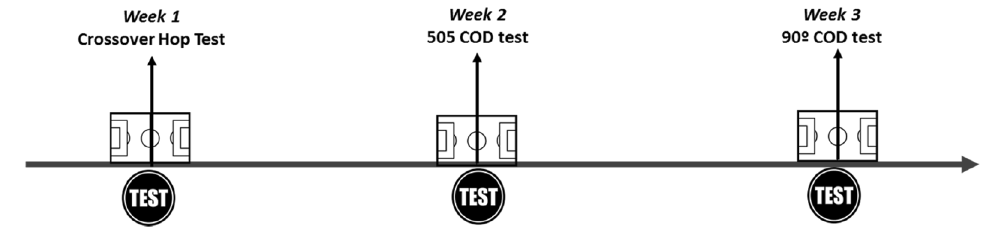
Figure 1. Schematic representation of a test day (see text for full description).